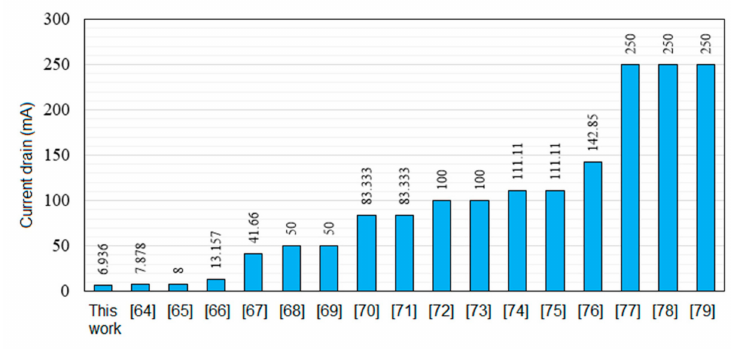
Figure 10. Comparison of current drain of the proposed monitoring system based on the sleep / wake scheme with the other existing